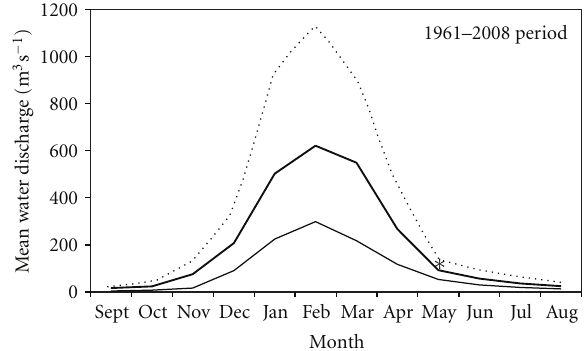
Figure 5: The Pilcomayo River hydrograph. The thicker high- lighted line represents mean river water discharge. The dotted line represents the 90th percentile water discharge values and the lower thinner line the 10th percentile water discharge values. The asterisk indicates mean water discharge on May 2009 (water sampling), 123.6 m 3 s − 1 . (Data from Misi´on La Paz monitoring station,